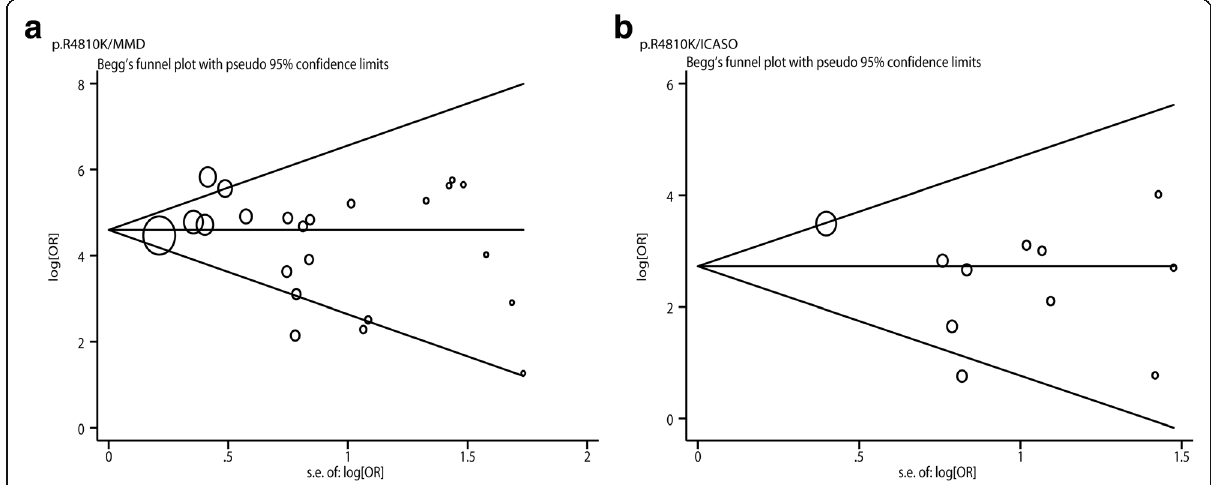
Fig. 5 Funnel plots for the association of RNF213 p.R4810K with MMD and ICASO under the dominant model. a Funnel plot of RNF213 p.R4810K and MMD under the dominant model. b Funnel plot of RNF213 p.R4810K and ICASO under the dominant model